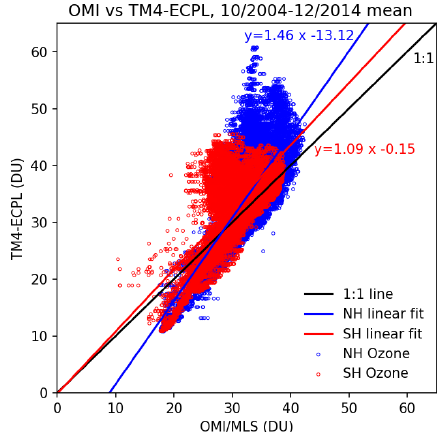
Figure 4. Mean tropospheric ozone column of model results versus observations (DU) for the period between October 2004 and De- cember 2014 for all grid cells of 1 ◦ × 1 . 25 ◦ shown in Fig. 3. Blue points are NH locations, and red points are SH locations. The black line is the 1 : 1 line. The red line is the linear fit of all the SH data with the fit equation in red text, where the blue line is the linear fit of the NH data with the fit equation in blue